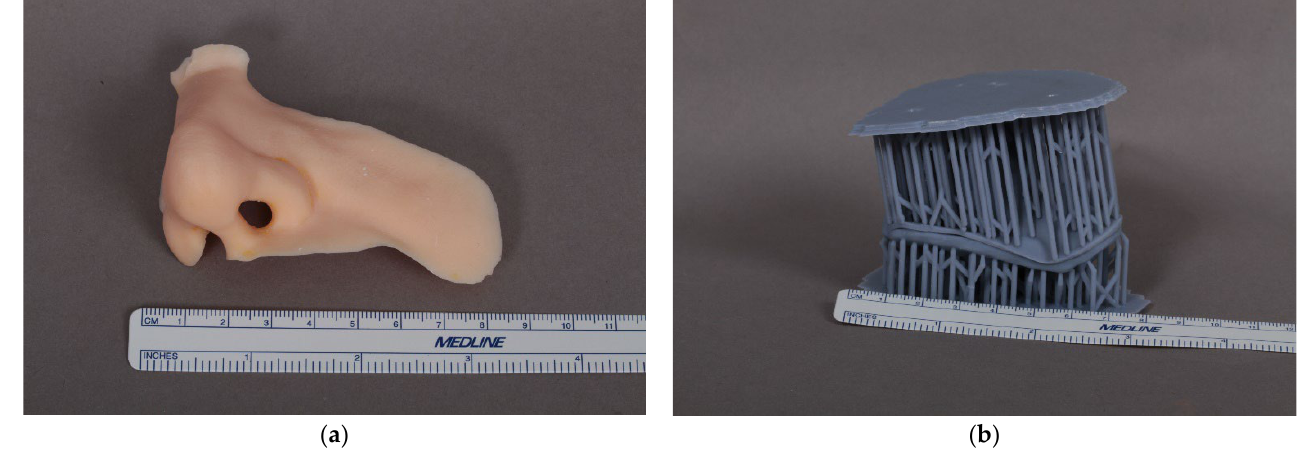
Figure 2. ( a ) A 3D printed trial prosthesis of the nose. ( b ) Molds printed on a 3D SLA